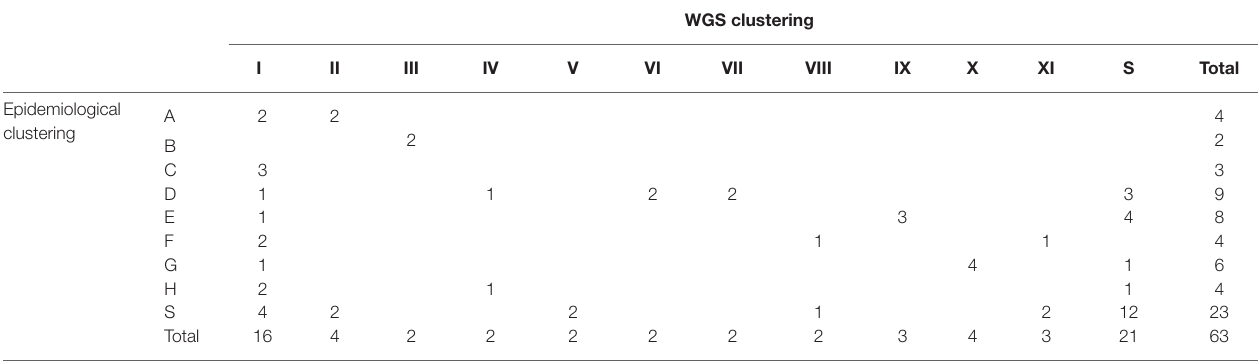
TABLE 1 | Contingency table comparing epidemiological clustering (A–H) vs. WGS clustering (I–XI) as the reference